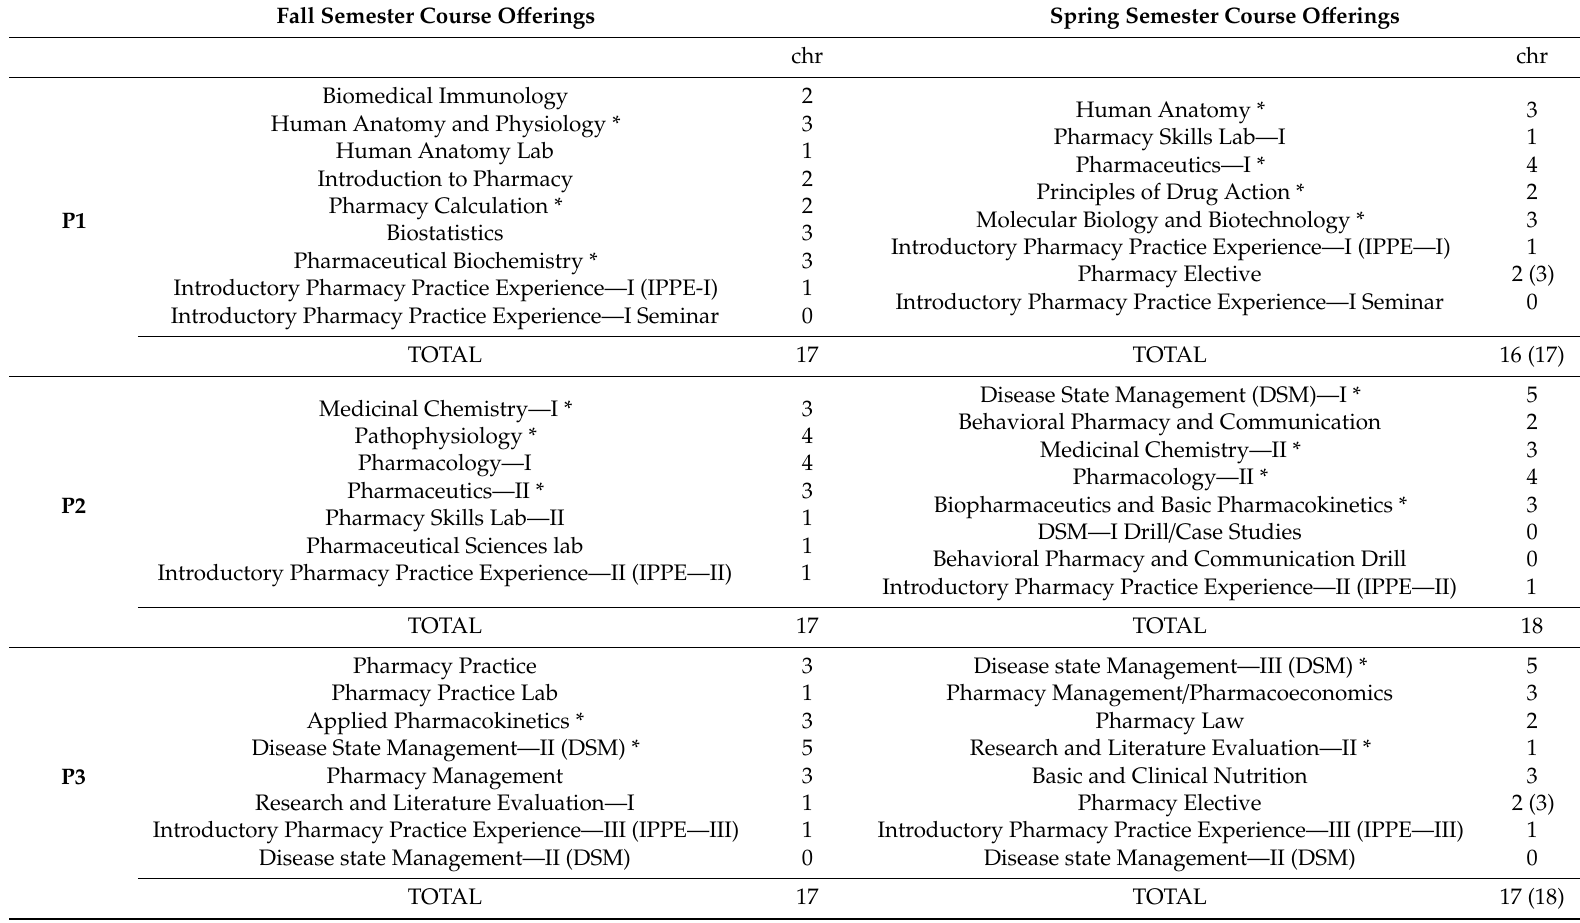
Table 1. Doctor of pharmacy (PharmD) curriculum